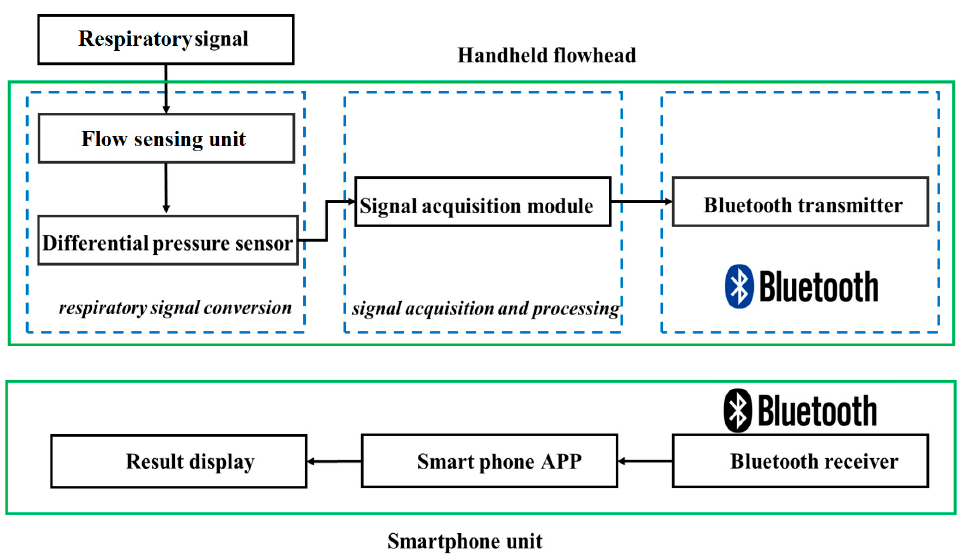
Figure 1. The diagram of the handheld wireless spirometer.